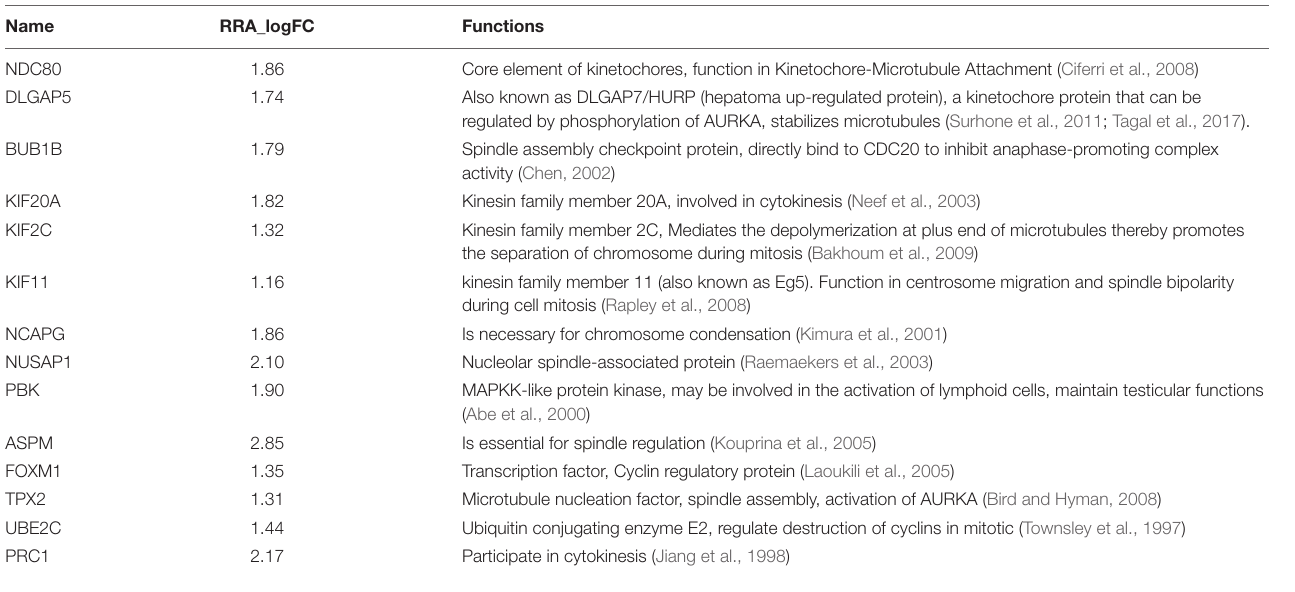
TABLE 1 | Details of hub